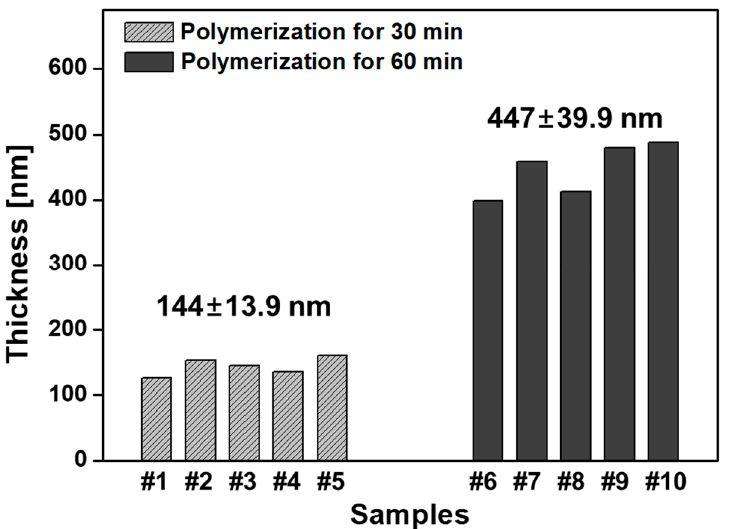
Figure 6. Thicknesses of PANI films grown on glass substrates by using the newly designed AP- plasma reactor system. Samples #1 to # 5 were polymerized for 30 min, and samples #6 to #10 were polymerized for 60 min.